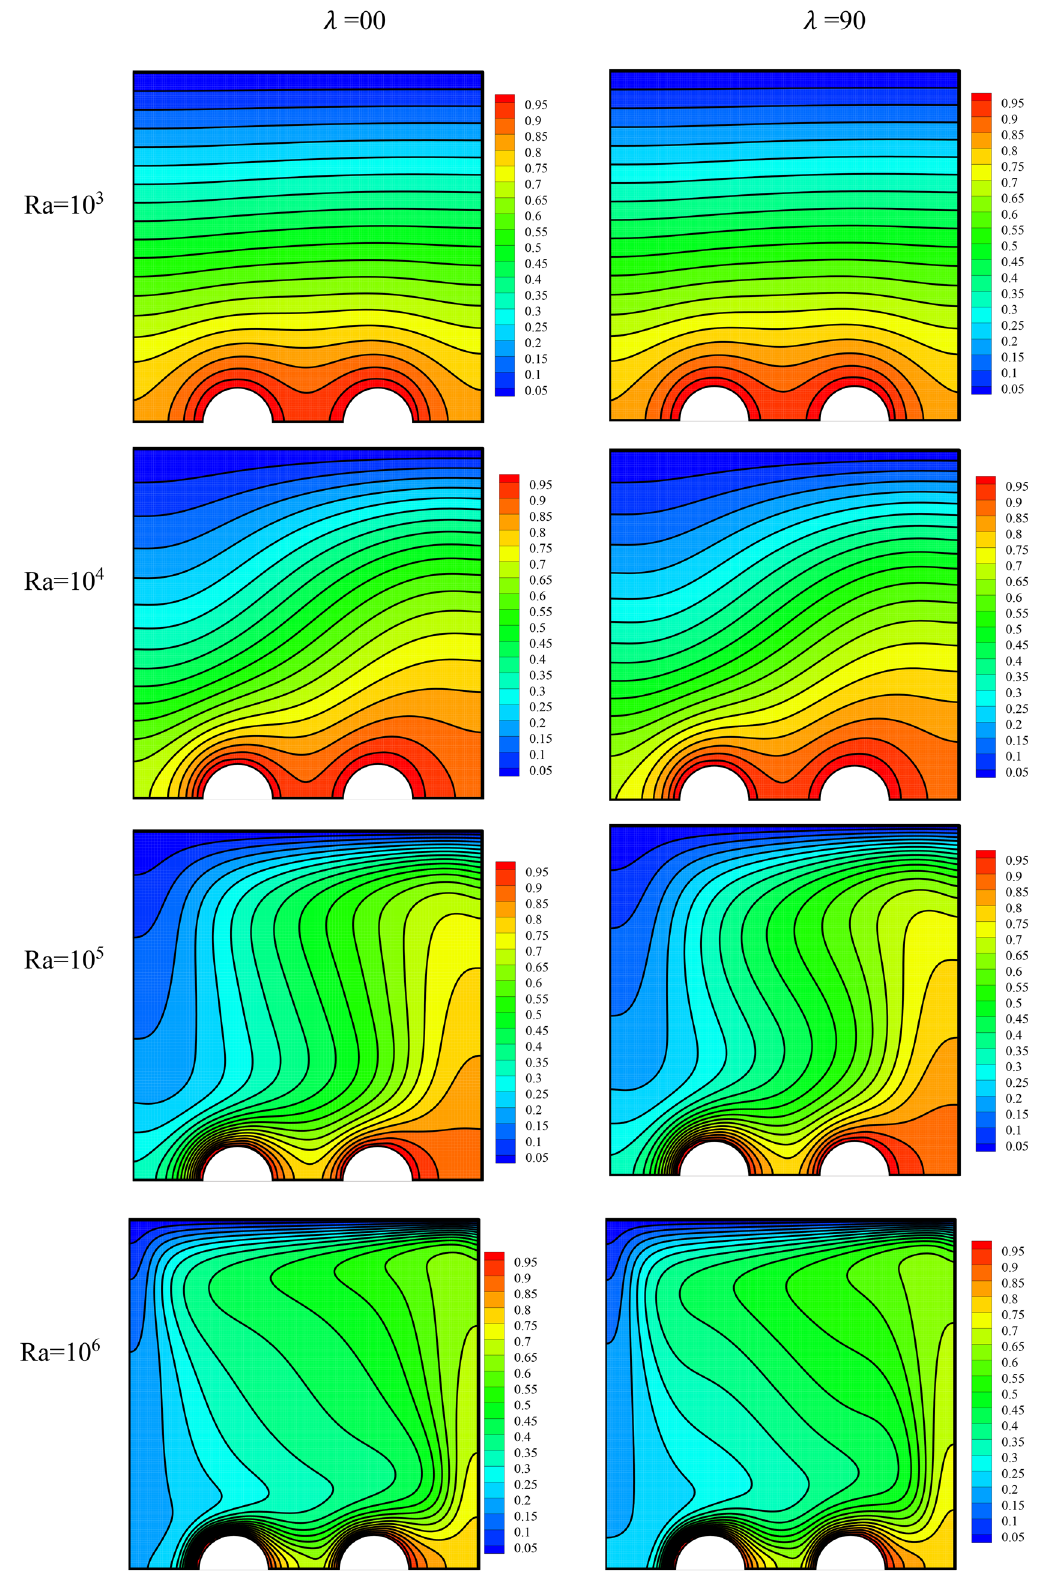
Figure 9. The temperature field for varying values of Ra and MF angle at φ = 0.3, γ = 45°, Ha = 20, Rad =